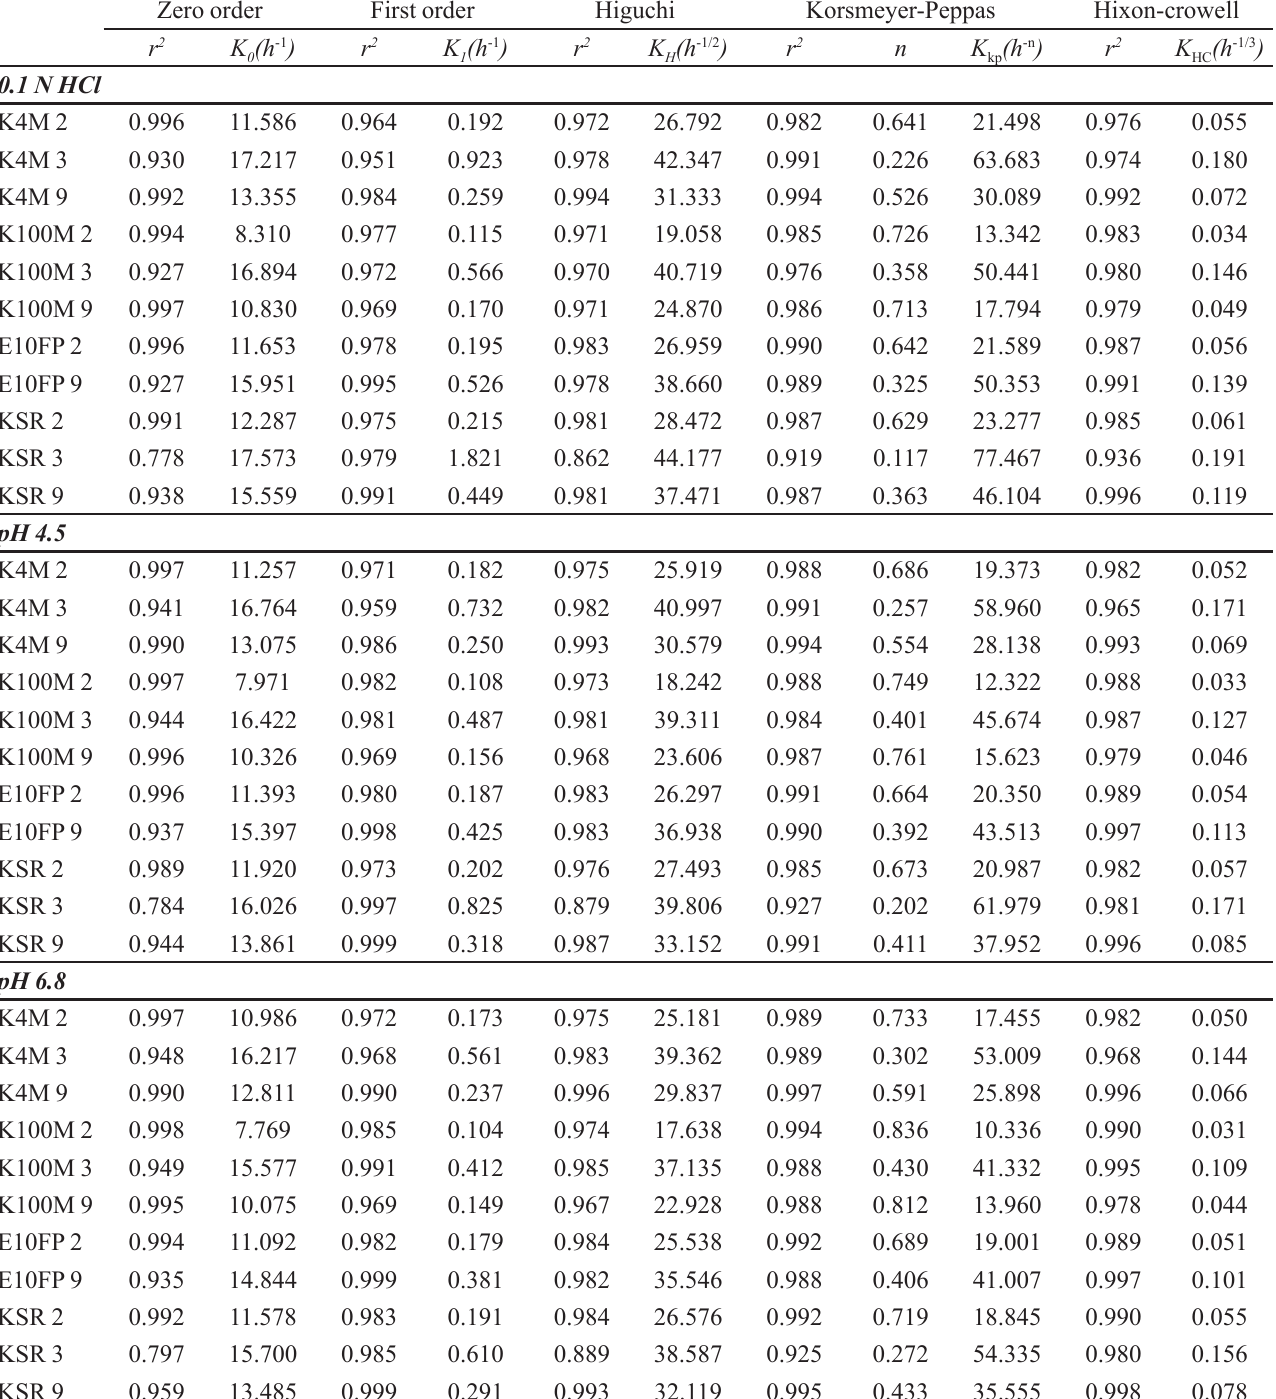
TABLE IV - Model dependent assessment of tizanidine